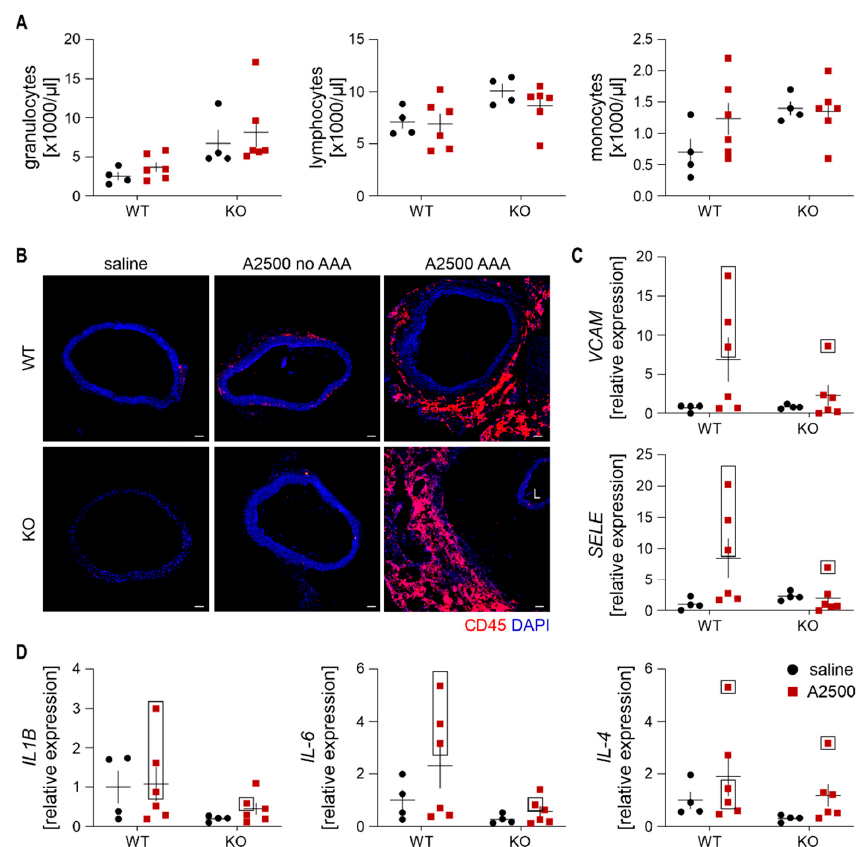
Figure 3. Enhanced immune cell infiltration is present only in the formed aneurysms. The mice were infused with either saline or angiotensin II at the dose 2500 ng/kg/min using the osmotic pumps for 14 days. ( A ) Quantification of circulating white blood cells subpopulations. Two-way ANOVA with Tukey’s post hoc test. ( B ) Immunofluorescent staining of infiltrating CD45 + cells within the aortic wall. CD45—red, nuclei- blue; L—lumen, magnification 200 × . Scale bar 50 µ m. ( C ) Relative expression of VCAM1 and SELE in the abdominal aortic wall. eEF2 was used as a reference gene. Two-way ANOVA with Tukey’s post hoc test; ( D ) Relative expression of IL-1b , IL-4 , and IL-6 in the abdominal aortic wall. eEF2 was used as a reference gene. Two-way ANOVA with Tukey’s post hoc test. Rectangle—mice which developed the